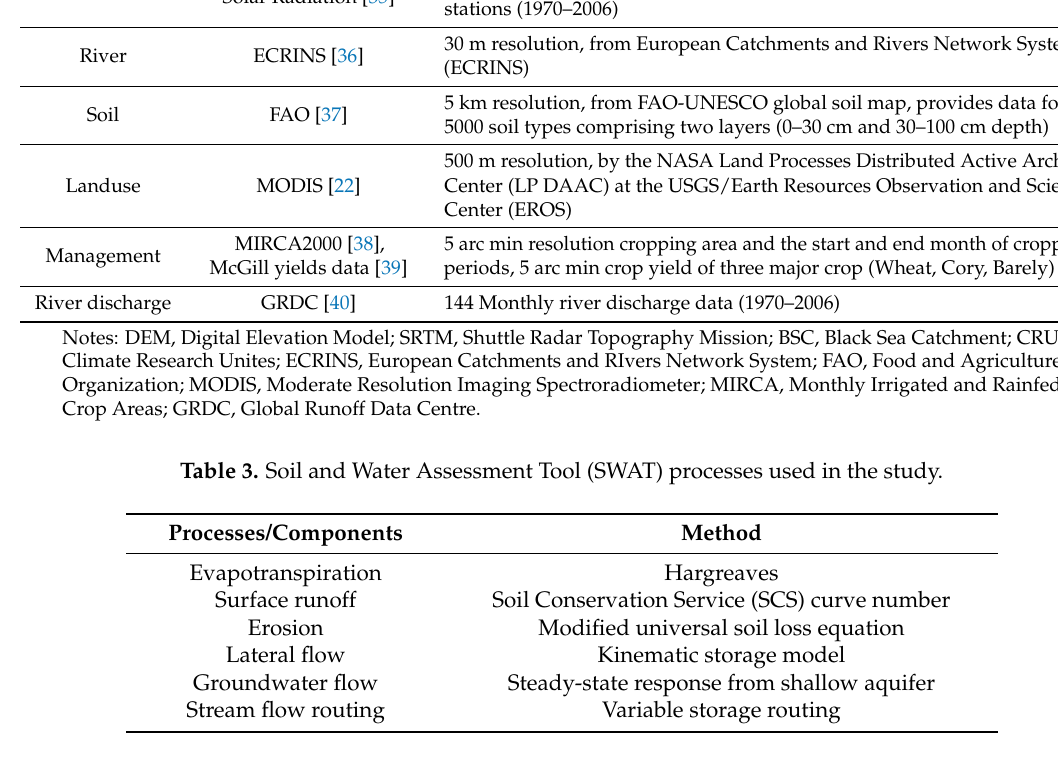
Table 4. An example of the simulated and observed stream flow along with the predictive uncertainty band for the two labeled river discharge stations in Figure 1 are presented in Figure 4. These are two examples of calibrated discharge stations, one at the border of Hungary and Romania and one in Romania. We ran the model and calibration simulations at a daily time scale. However, given the scale of the watershed, the outputs were extracted at monthly time